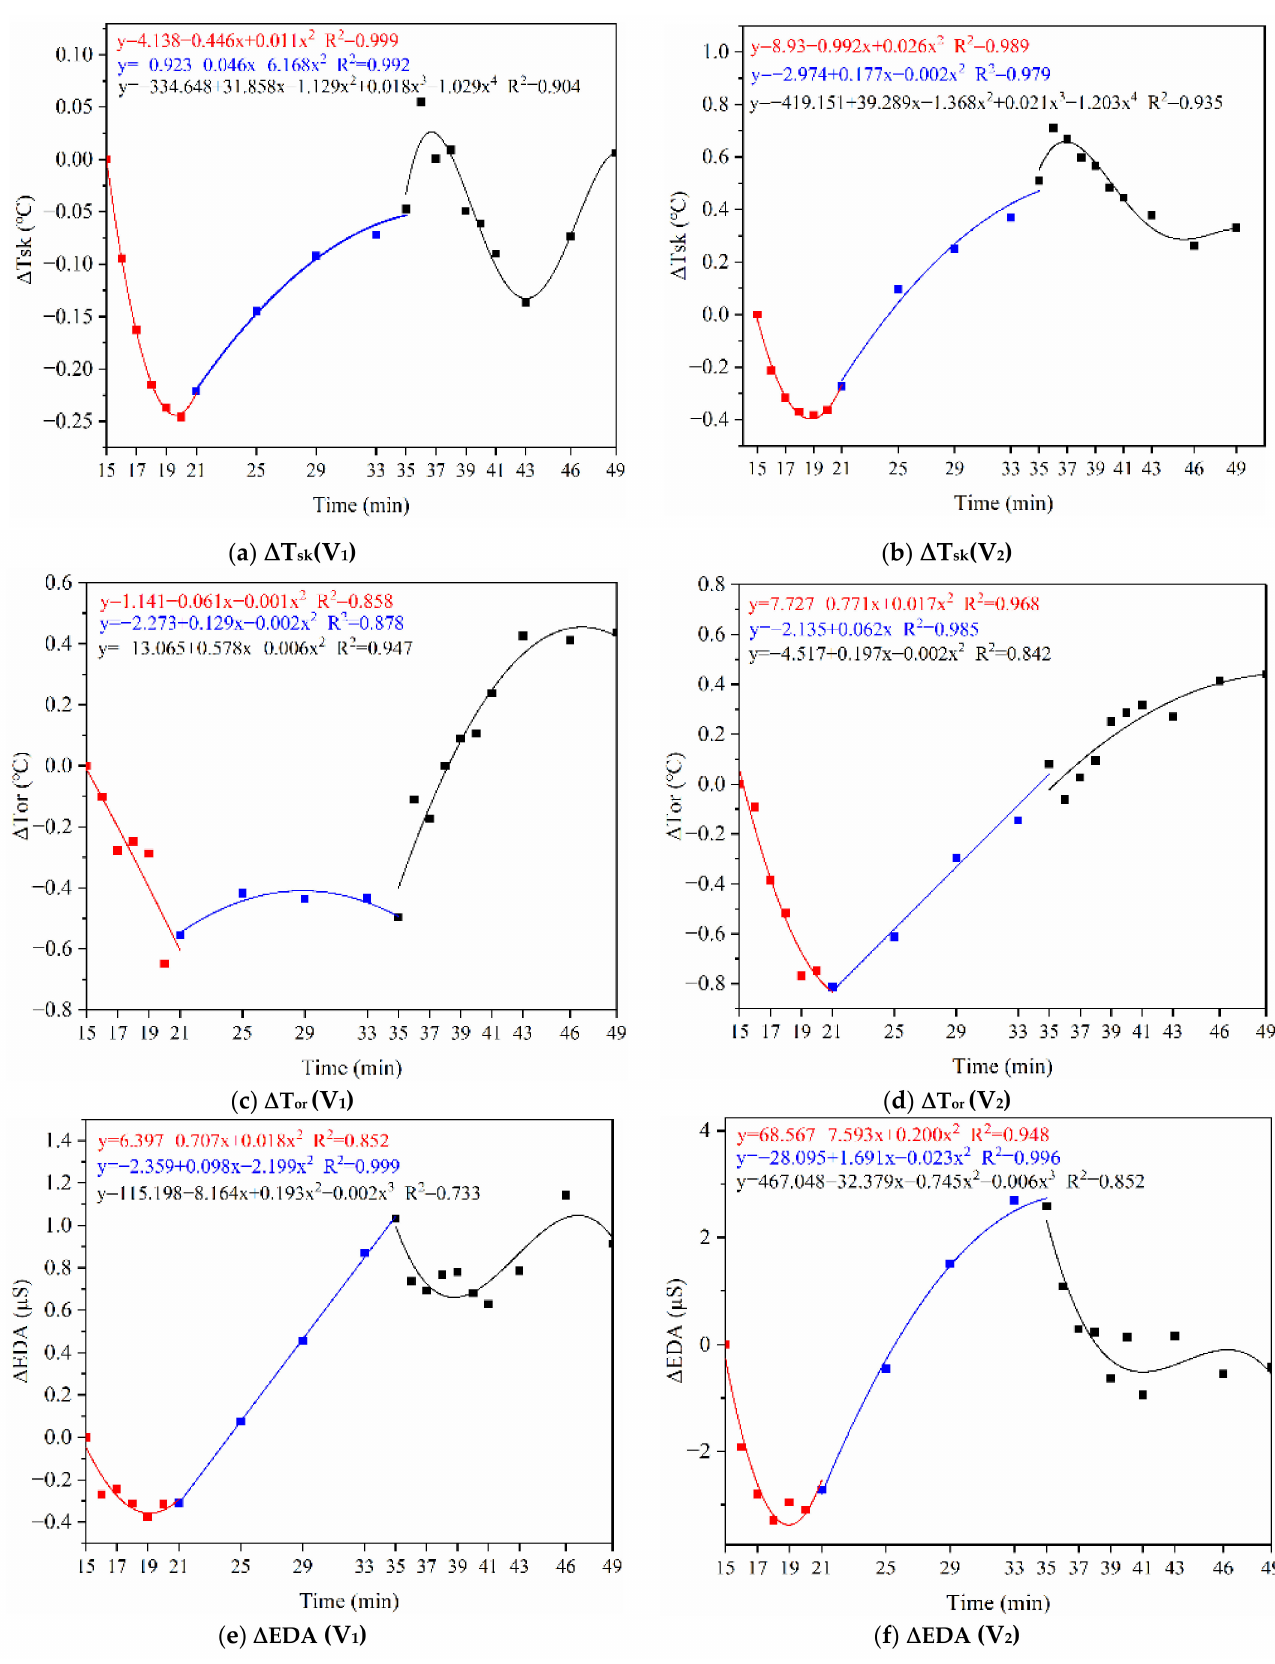
Figure 11. The average change of physiological